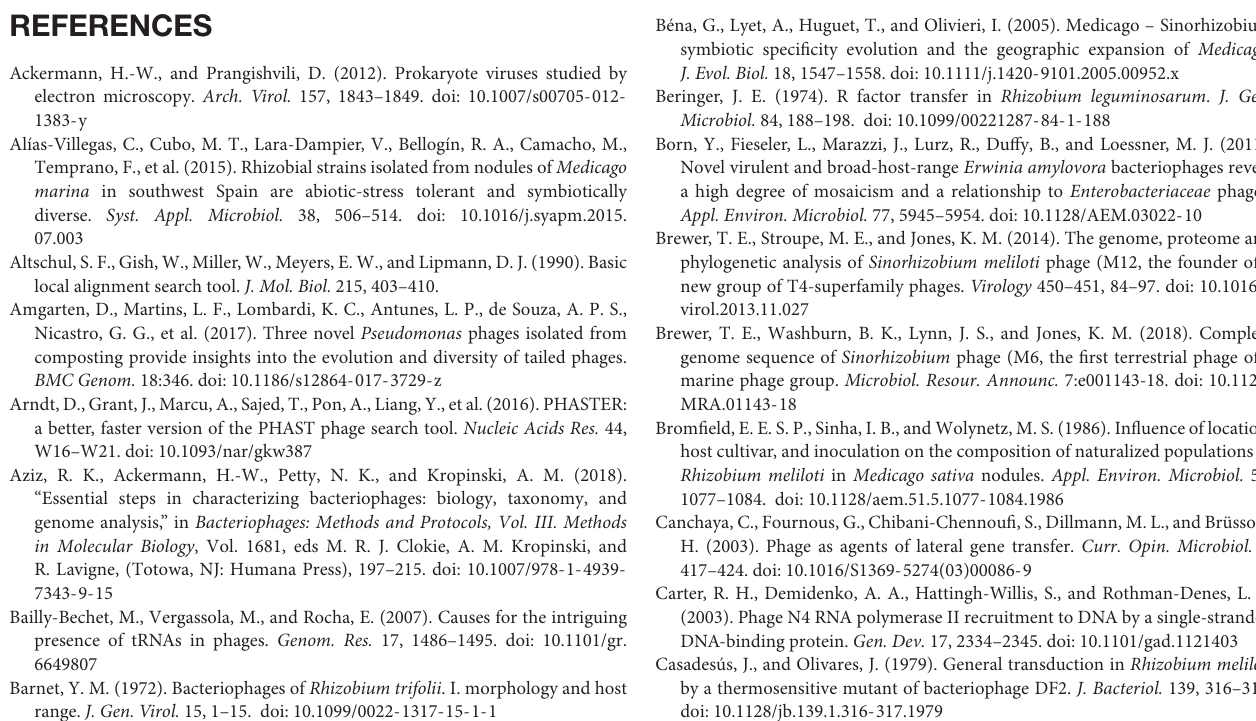
figure. EB contributed to the DNA sequencing. ES made possible the DNA sequencing and provided critical writing of the manuscript. All authors read and approved the final